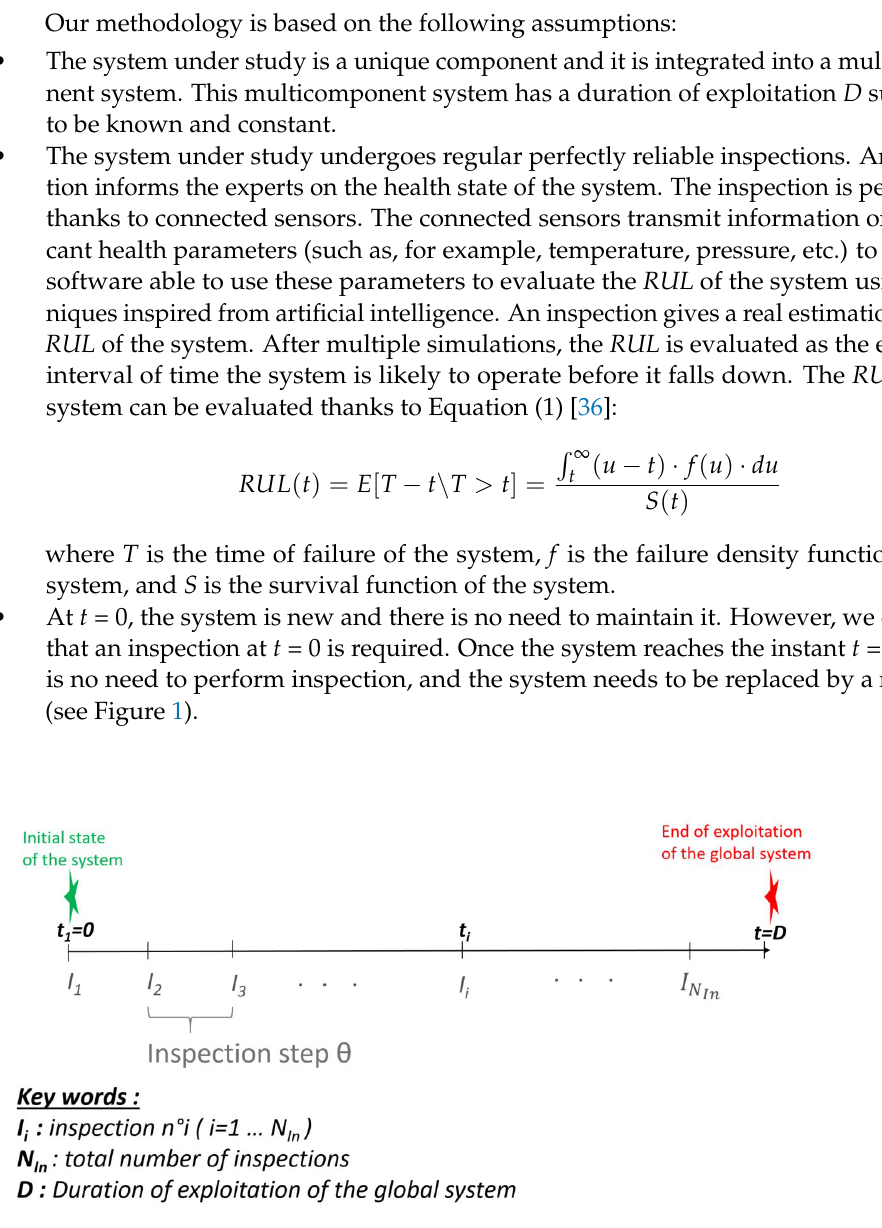
Figure 1. Inspection